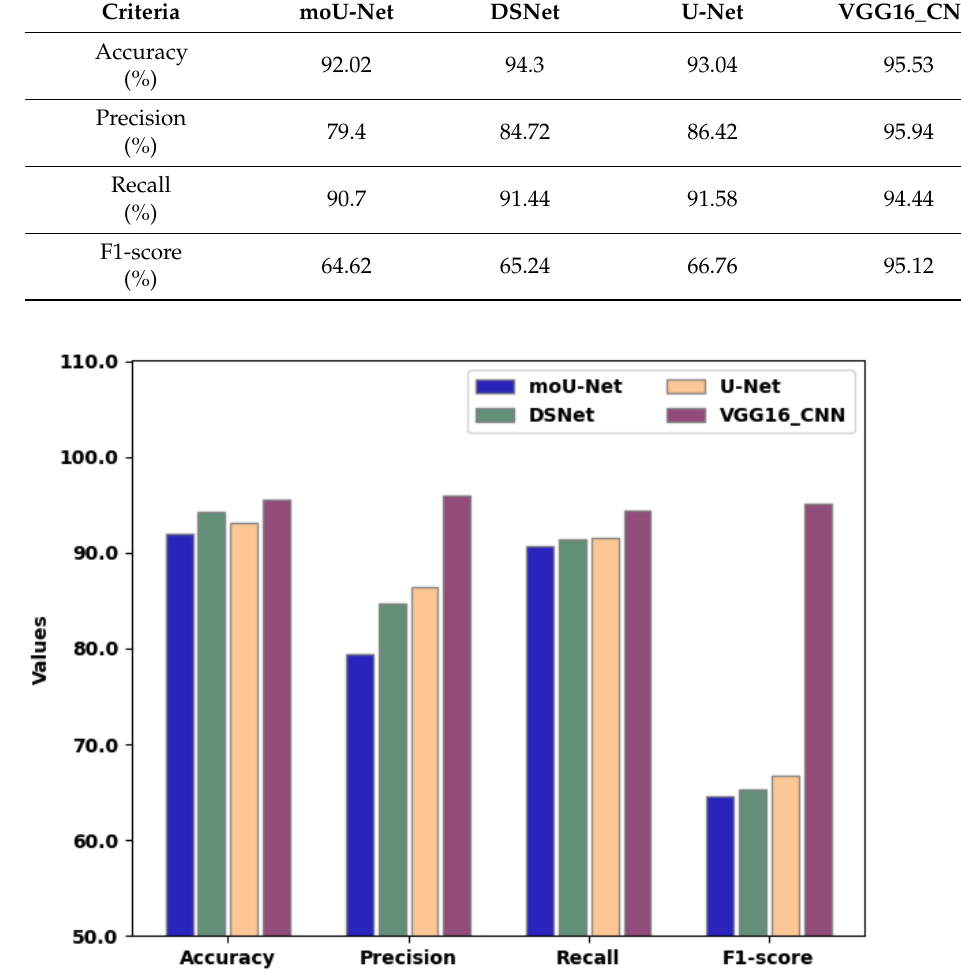
Figure 12. Overall comparison of existing techniques and the proposed method.